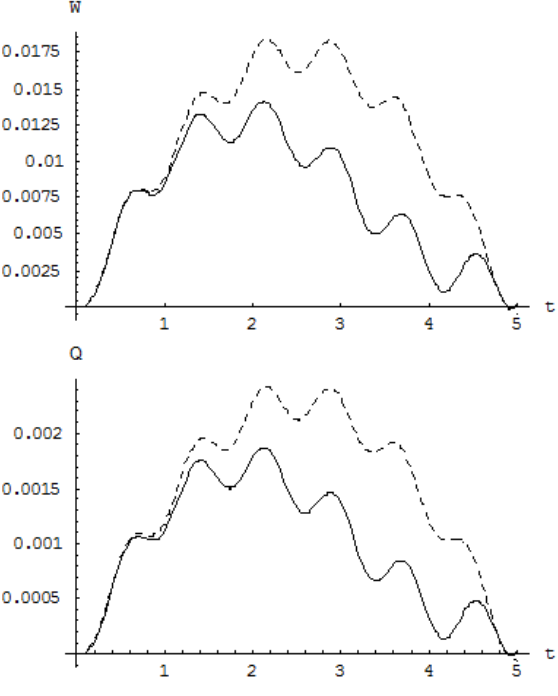
Figure 17: The influence of the load model for R = 150 m and υ = 10 m/s and ( - - - ) Concentrated load P = Mg , ( ___ ) Damped mass- load M